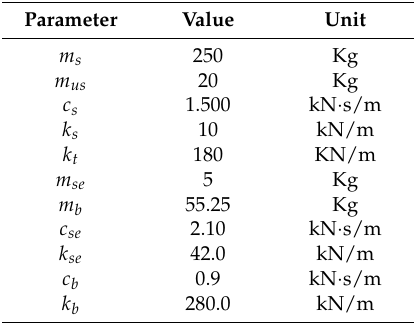
Figure 2. Measured and simulated acceleration transmissibility of the passive seat. Table 3. QvM and estimated parameters of the passive seat suspension and the dummy.